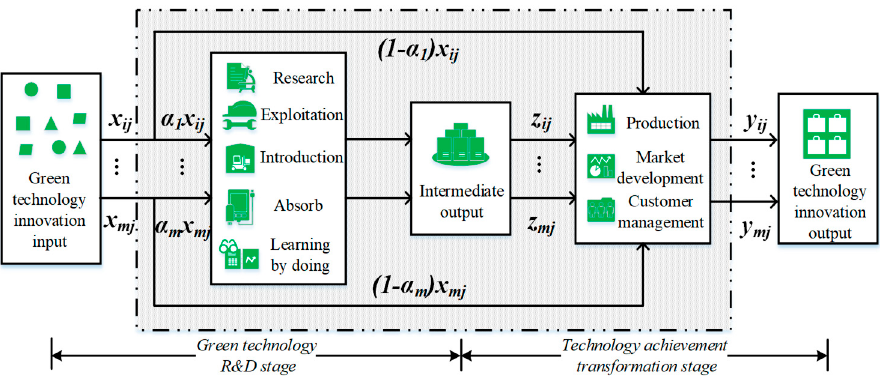
Figure 1. The two stages of industrial enterprises’ green innovation activities with shared